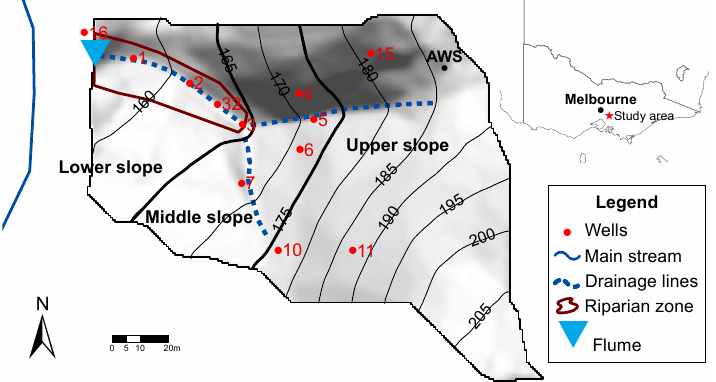
Figure 2. The study site location within Australia and a hill shaded DEM, topography and sampling site locations at RBF. In this figure the black circles show shallow groundwater sites, the red circle shows the soil moisture site and the blue triangle demonstrates the catchment flume.